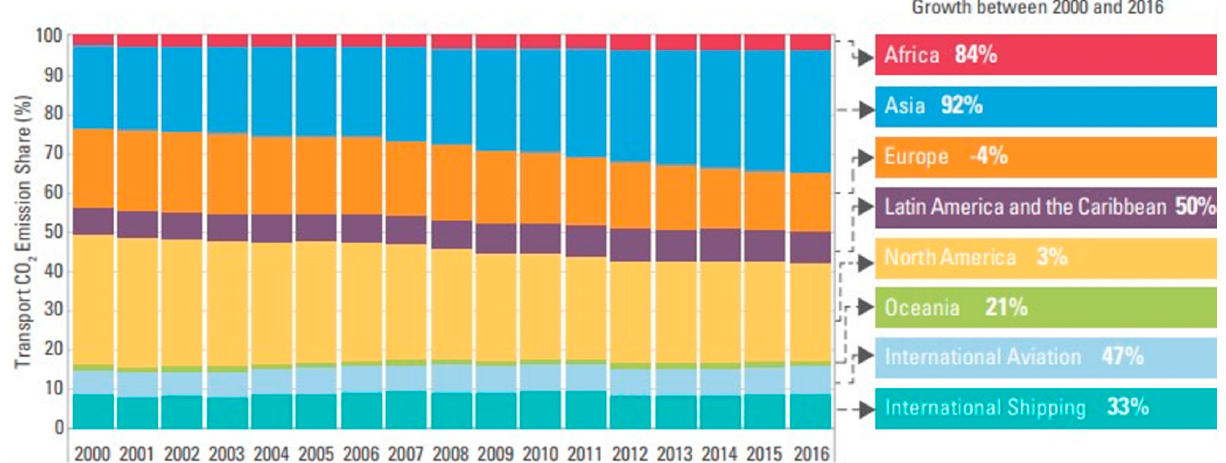
Figure 1 . Regional share of CO 2 transport emissions growth between 2000 and 2016 [13] . Figure 1. Regional share of CO 2 transport emissions growth between 2000 and 2016